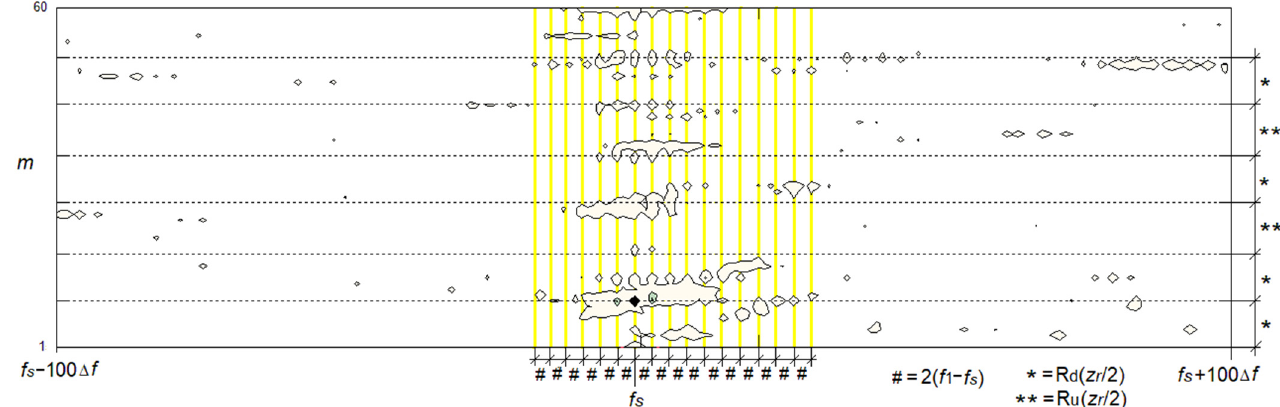
Figure 4. F-F image of the frequency spectrum of the vibration acceleration of the outer casing of a healthy motor with marked reference-like pattern associated with rotor grove-tooth frequency. R d is the rounded down and R u is the rounded up number operation.